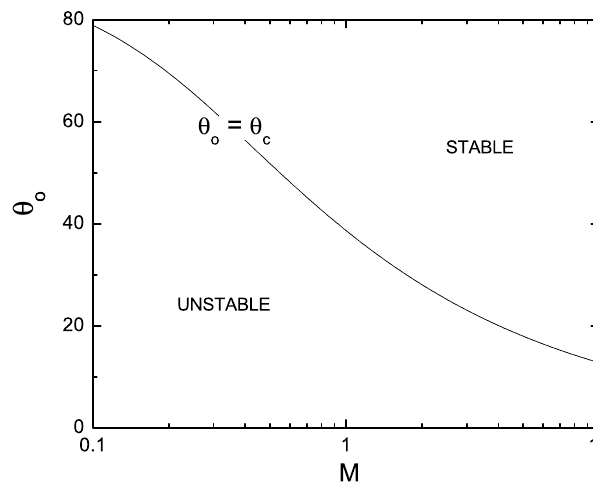
Fig. 2. The normalized growth rate γ as a function of k for m = 1 . 2, 2 and 3. Fig. 3. The instability condition, relations (29), with the critical latitude θ c as a function of the effective rotational Mach number, M , separating the parameter space into stable and unstable